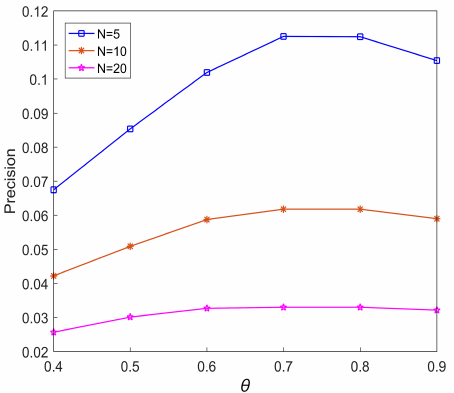
Figure 1. Parameter θ setting for New York City dataset.